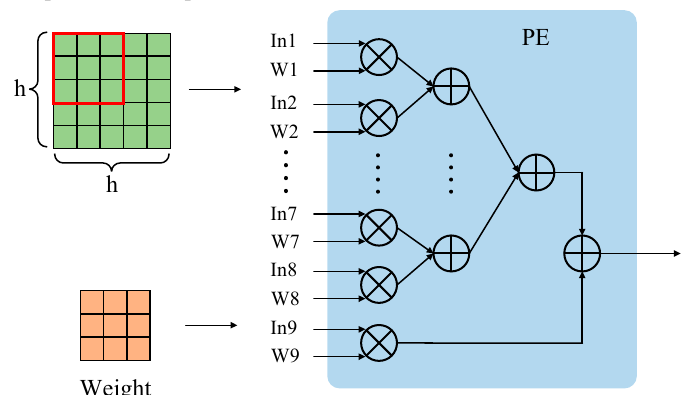
Figure 6. Design of a 3 × 3 convolution operator. Generally, the input and output of a convolution layer are composed of multiple two- dimensional feature maps. Figure 7 shows the computation process of a convolution layer with N input channels and M output channels. The size of each output feature map is R × C. The weight parameter is composed of multiple convolution kernels, each with a size of K and number of N × M.